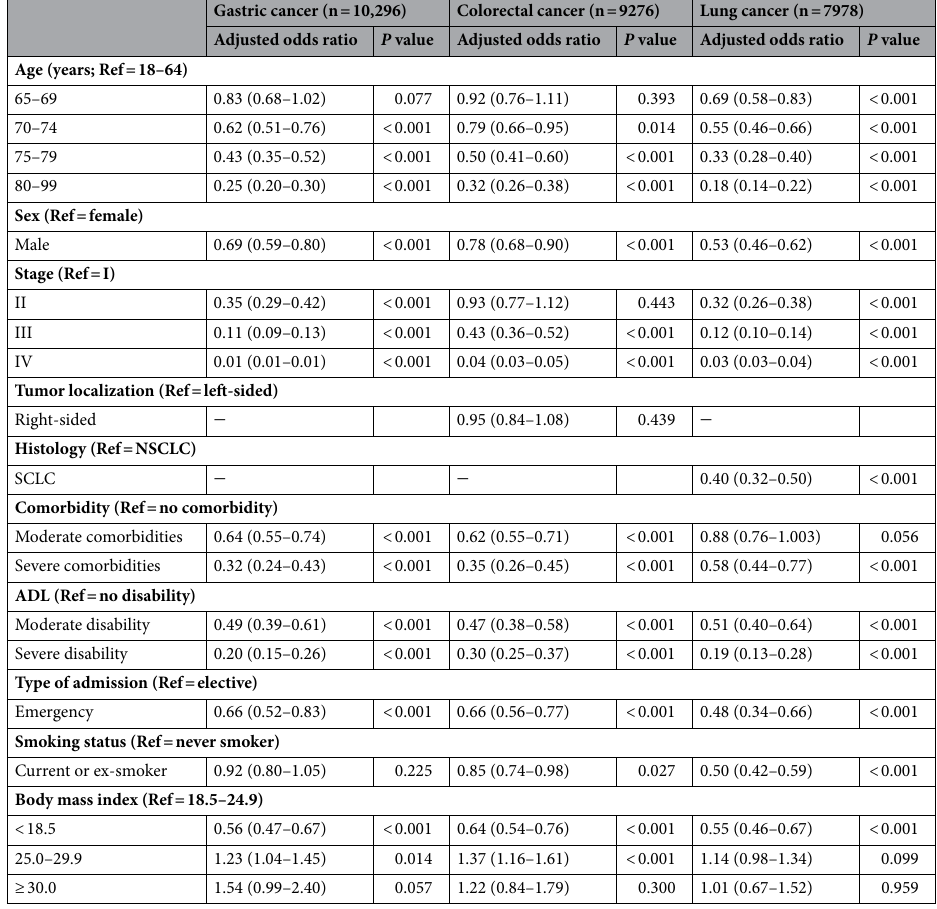
Table 2. Association of prognostic factors with 3-year overall survival in patients with gastric, colorectal, and lung cancer using data from multiple imputation models. ADL activities of daily living, NSCLC non-small cell lung cancer, Ref reference, SCLC small cell lung